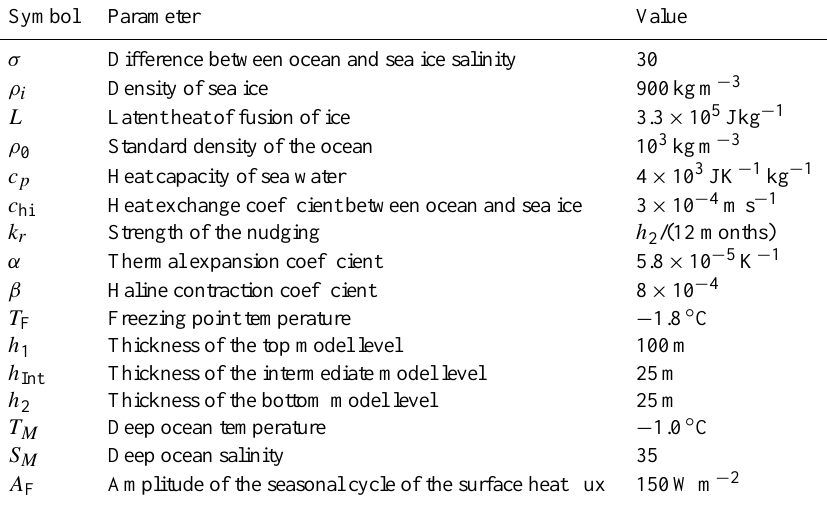
Table 2. Description of the parameters used in the simple